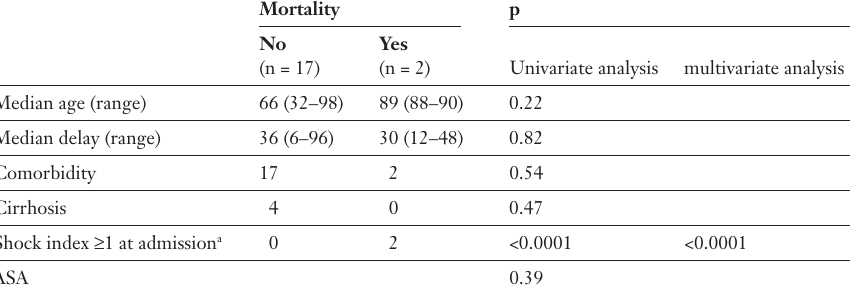
Relation between mortality and clinical variables among pa- tients treated with